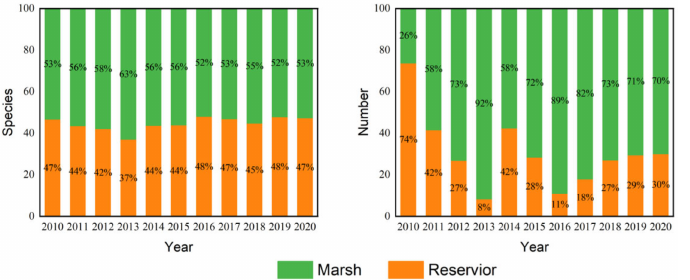
Figure 3. Proportion of species and number of waterbirds in different habitats in Xianghai Nature Reserve.